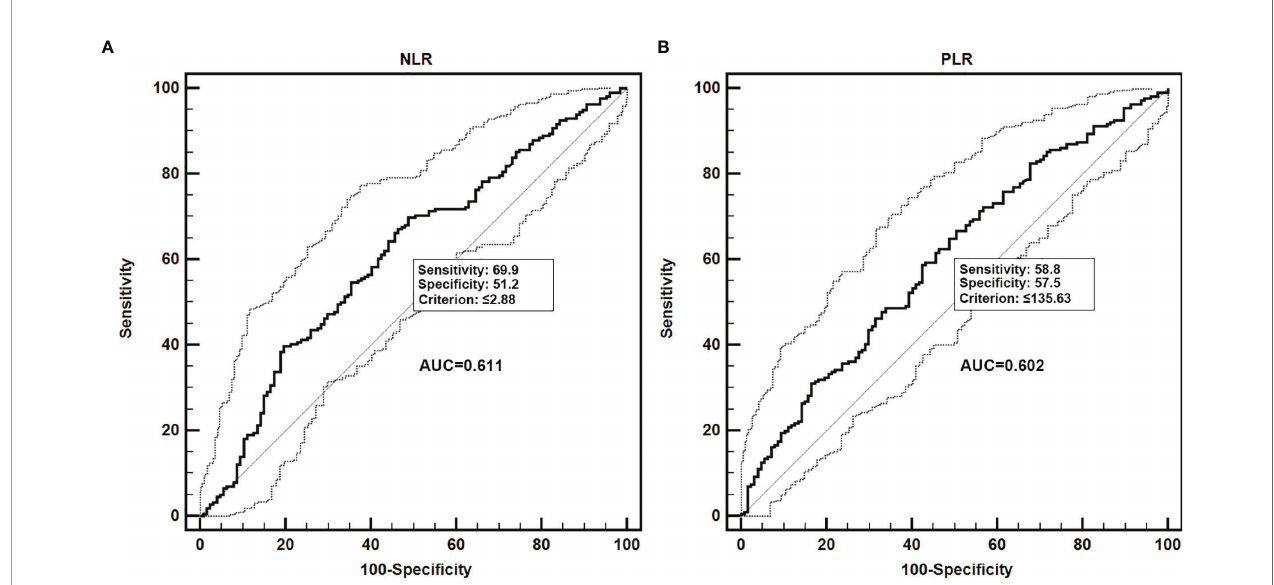
FIGURE 2 | Receiver operating characteristic (ROC) curves to assess the best predictive values of NLR and PLR for identifying the risk of sarcopenia in patients with renal cancer carcinoma. NLR, neutrophil – lymphocyte ratio; PLR, platelet – lymphocyte ratio. (A) ROC curve of NLR; (B) ROC curve of